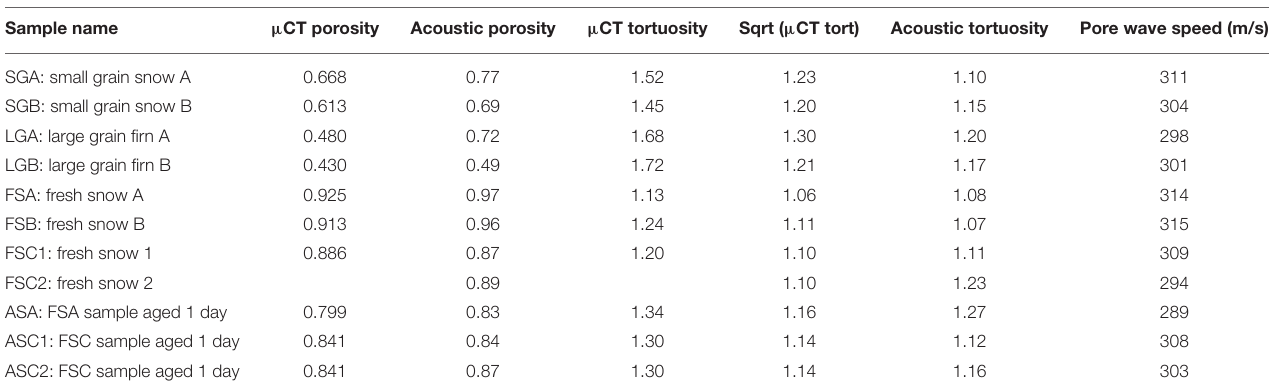
TABLE 2 | Comparison of µ CT and acoustic measured porosity and tortuosity